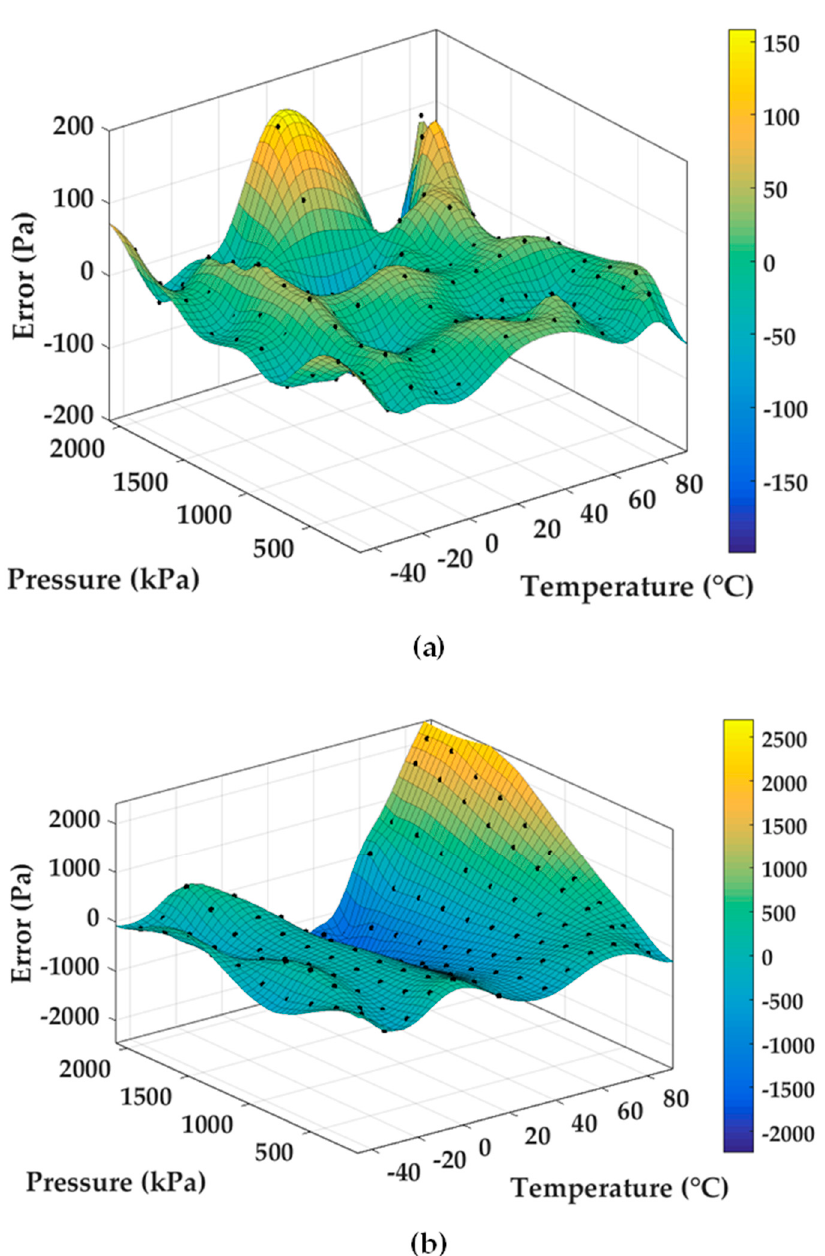
Figure 6. Experimental results: ( a ) pressure’s surface fitting of the temperature compensation method based on differential outputs and a temperature sensor applied on the developed sensor and ( b ) pressure’s surface fitting of the self-temperature compensation method applied on the developed sensor .